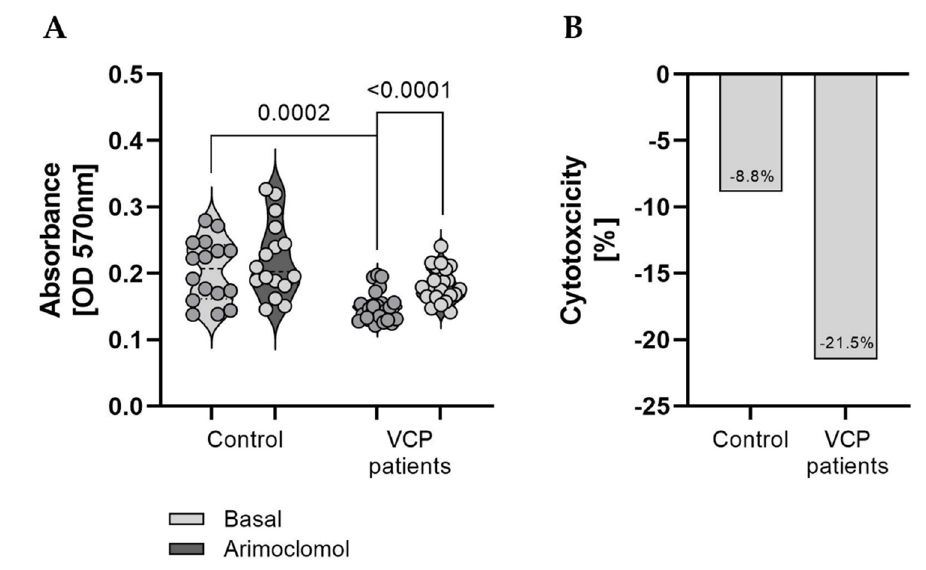
Figure 3. Studies of cellular fitness on VCP –mutant and control fibroblasts. ( A ) Decrease of pro- liferation in patient–derived fibroblasts compared to controls under basal conditions. A significant effect of arimoclomol treatment on proliferation of patient–derived cells was observed. Basal fitness levels in control and VCP –patient fibroblasts are displayed on the left and fitness levels after treatment with arimoclomol are displayed on the right for each group, respectively. ( B ) Arimoclomol treatment reduced cytotoxicity in patient and control fibroblasts with a higher extend in patient derived cells.